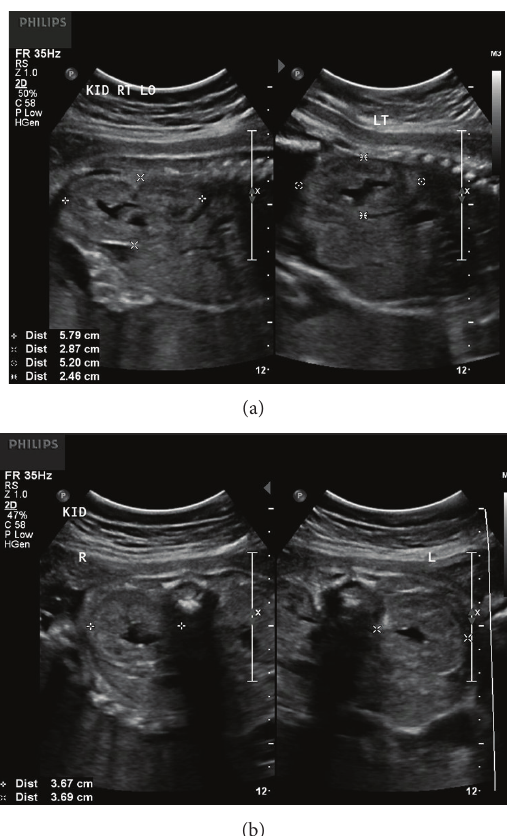
Figure3:(a)Longitudinalimageofthefetalrightkidneyat35weeks and 1 day of gestation. Notice the significantly enlarged renal size. (b) Transverse image of the fetal kidneys at 35 weeks and 1 day. Notice how the kidneys essentially occupy the entire fetal abdomen. Anhydramnios was noted at this gestational